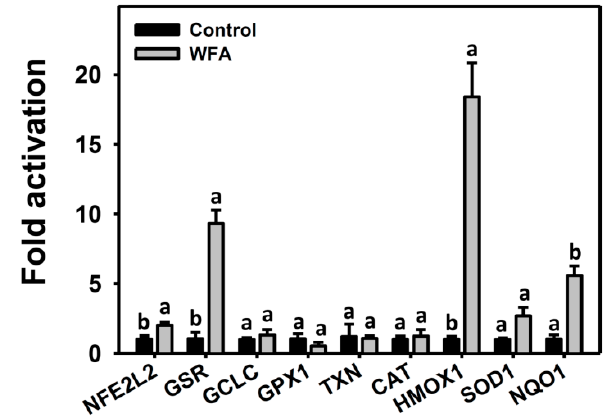
Figure 6. mRNA expressions of antioxidant genes of low concentrations of WFA in oral cancer cells. Cells were treated with or without 0.5 µ M of WFA for 24 h. Treatments (control vs. WFA) without the same labels (a,b) indicate the significant difference. p < 0.05~0.01. Data, mean ± SD ( n = 2).